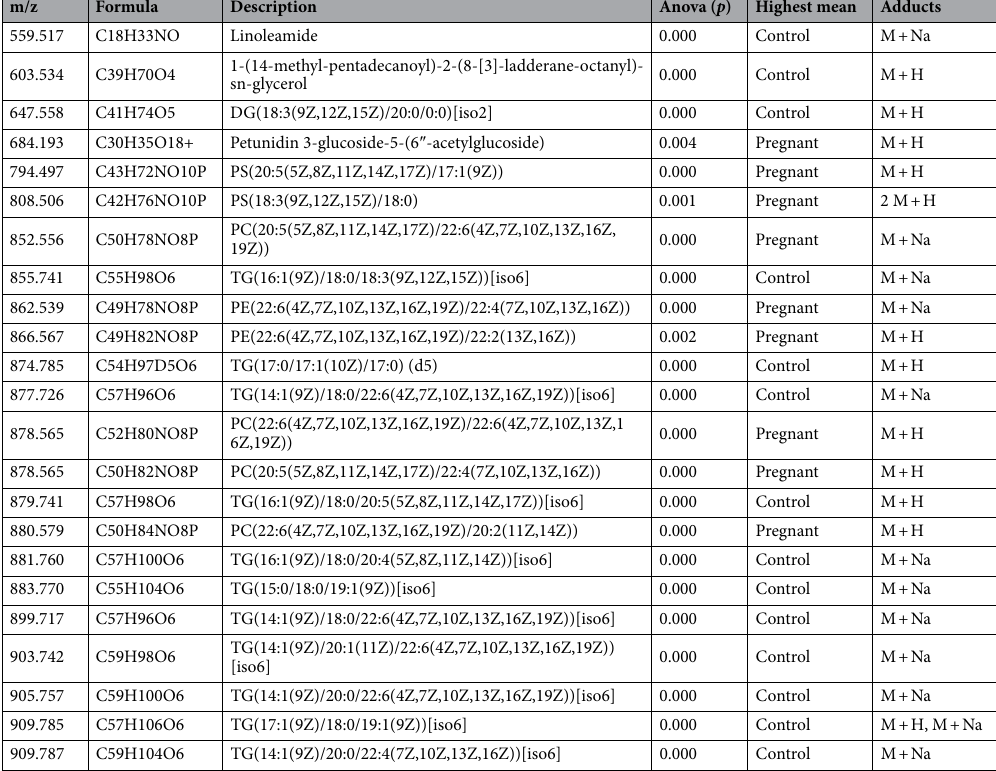
Table 1. Screened individual skin surface lipids (SSL) lipids most important for distinguishing between the pregnant and control groups. TG triacylglyceride, PC phosphatidylcholine, PS phosphatidylserine, PE phosphatidylethanolamines, DG diacylglycerol.